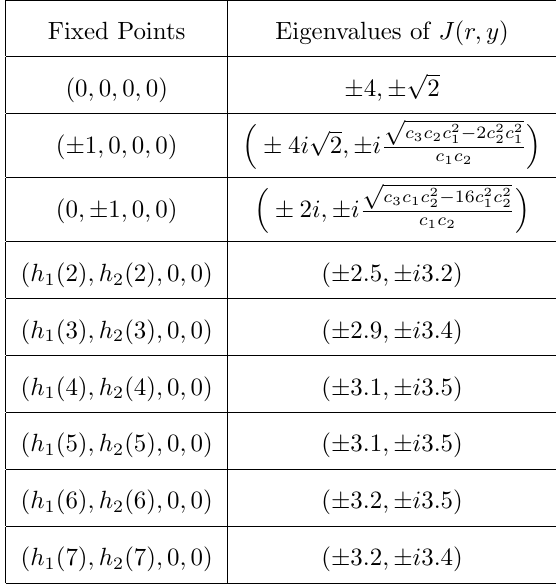
Table 4. Eigenvalues of the Jacobian J ( r; y ) at the (cid:12)xed